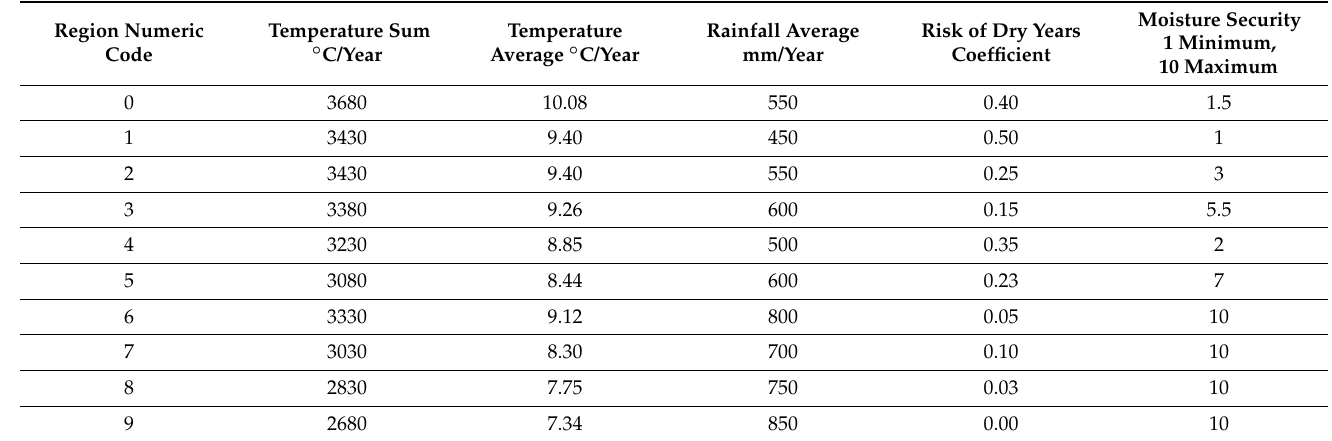
Table A2. Description of the climatic